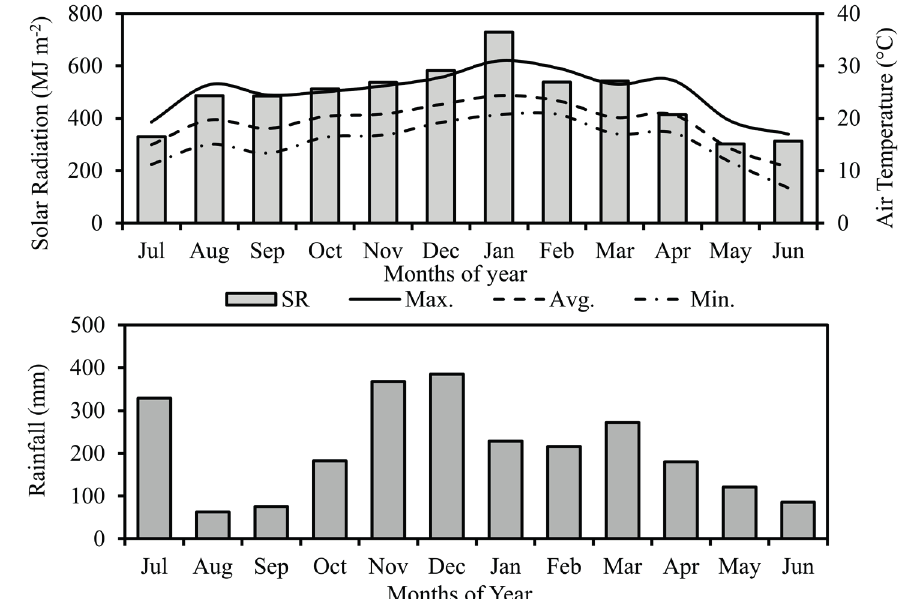
Figure 2 - Monthly average values of minimum, maximum and average temperature, accumulated incident solar radiation, and accumulated rainfall during the experimental period (07/02/2015 to